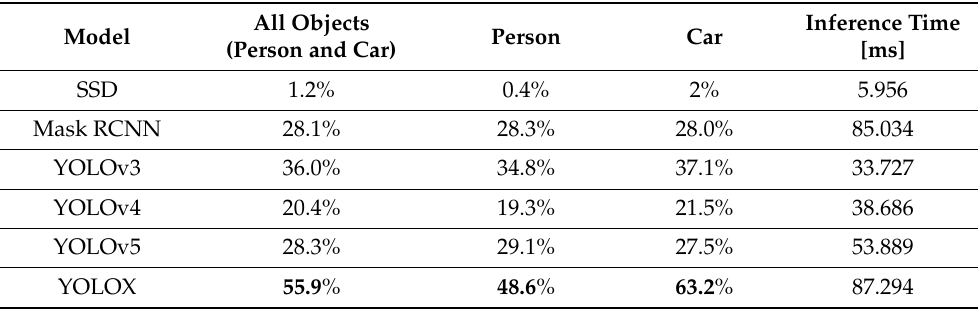
Table 5. Comparative results of different pretrained models on color images for the persons and cars detection together, as well as separately, on the test SWIR dataset. Results are presented with Average Precision (AP) 0.5:0.95 using the COCO_eval